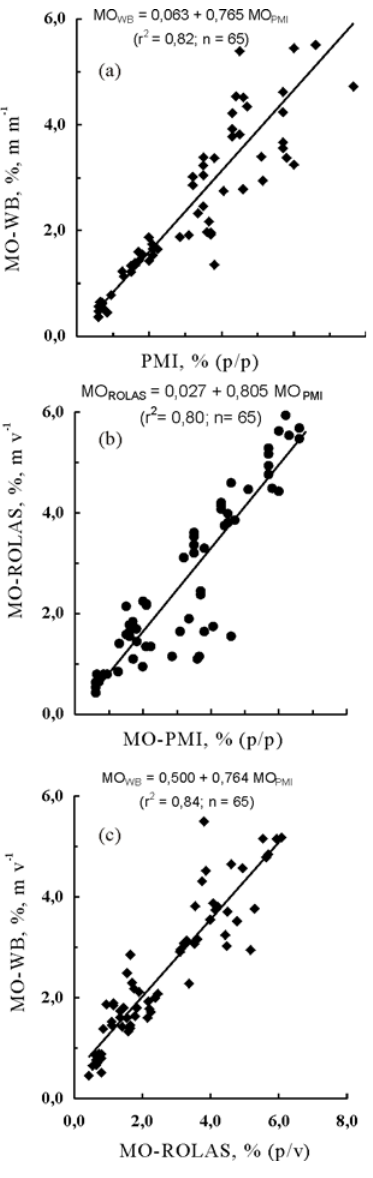
Figura 2. Relação entre os teores de matéria orgânica (MO) determinada com os métodos Walkley- Black (WB), perda de massa por ignição (PMI) e solução sulfocrômica (ROLAS), em amostras de solos de diversas unidades de mapeamento e da Depressão Central do Rio Grande do